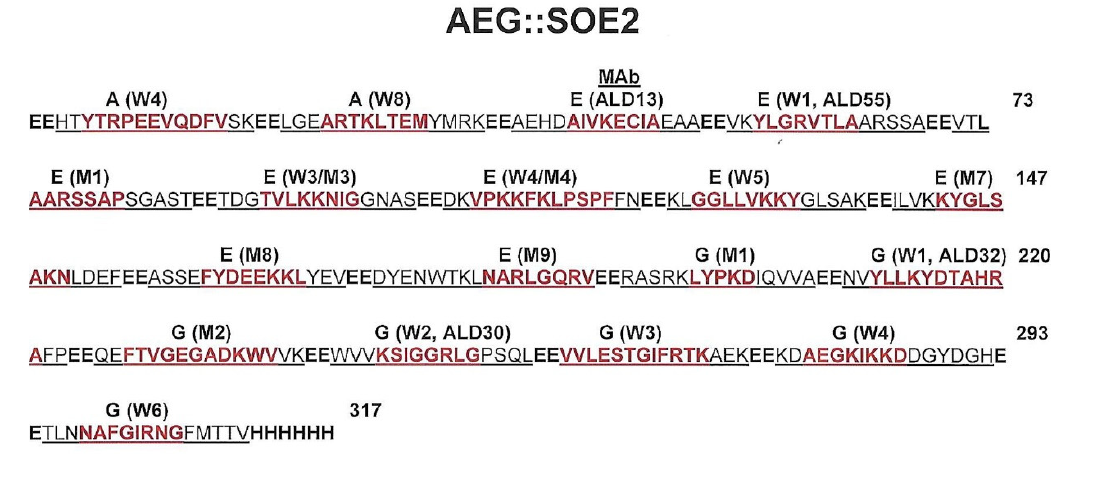
Figure 1. Linear amino acid sequence of the chimeric, recombinant AEG::SOE2 protein. The peptide-epitope sequences linked by EE amino acids are underlined. Epitopes within the protein–epitope sequences are colored red. The letters A, E, and G refer to amino acid sequences derived from respective proteins. The epitopes were detected by either or both pooled women (W) or men (M) sera, as indicated, and the number next to W and M represents the order the epitope was identified within the protein during epitope mapping on the SPOTs system.